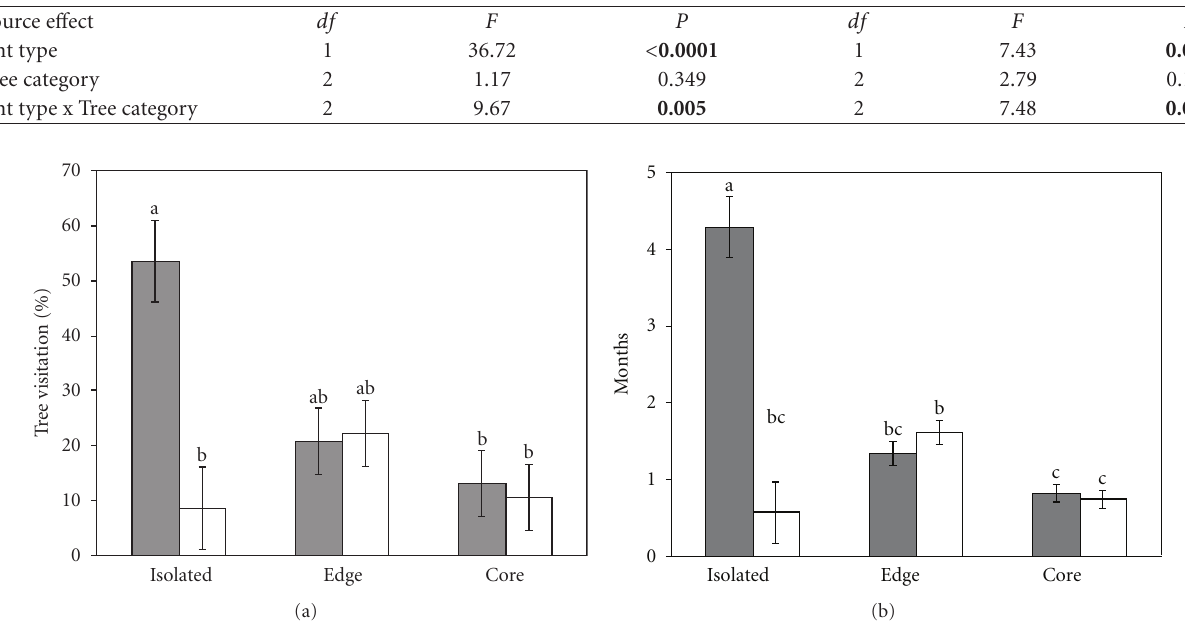
Figure 3: Foraging activity at invaded forest fragments is shown as the percentage (mean ± SE) of visited trees (a) and the months they remain visited (b) per tree category in 2006. Bars showing trees visited by Lasius neglectus are in grey and visited by native ants are shown in white. Di ff erent letters showed statistical di ff erences of post hoc comparisons (tree category x ant type e ff ect) ( P < 0 .